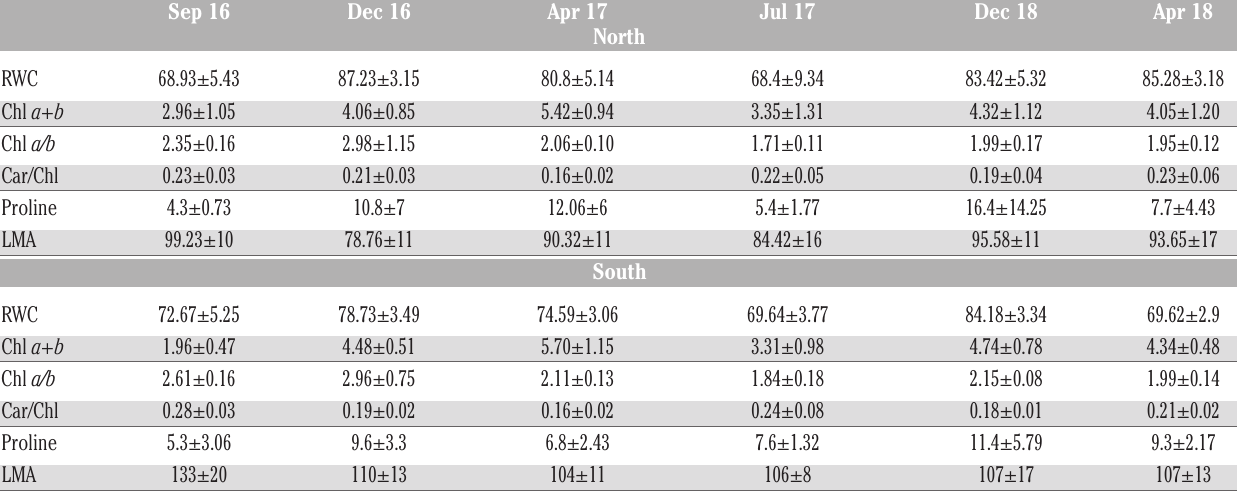
Figure 3. Maximum photochemical efficiency of PSII (Fv/Fm) in randomly selected leaves of A. spinosa in the North and the South over the 2016-2017-2018 annual cycles. Values represent mean ± SE, n=30. Asterisks indicate significance levels for the compar- ison between the two sites within each season by student’s t-tests (**P<0.001; Table 1. Relative water content RWC, Total chlorophyll content Chl a+b (µg mg -1 FM), chlorophyll a/b ratio Chl a/b , Total carotenoids to total chlorophyll content ratio (Car/Chl), Free proline content ( mol g -1 FM), Leaf mass area LMA (g m -2 ) in randomly selected leaves of A. spinosa in the North and the South over the 2016-2017-2018 annual cycles. The standard error is shown. Values represent mean ± SE, n=30.